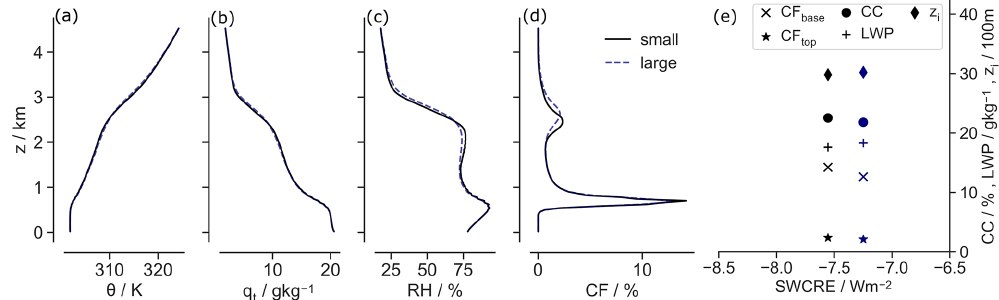
Figure B1. Profiles of second-day domain-averaged (a) potential temperature θ , (b) specific humidity q t , (c) RH and (d) CF, as well as (e) mean values of total CC, cloud fraction at base (CF base ) and top (CF top ), LWP and inversion height ( z i ) at 1km resolution on two different domain sizes: 50 × 50km (black, small) and 500 × 500km (dashed blue,